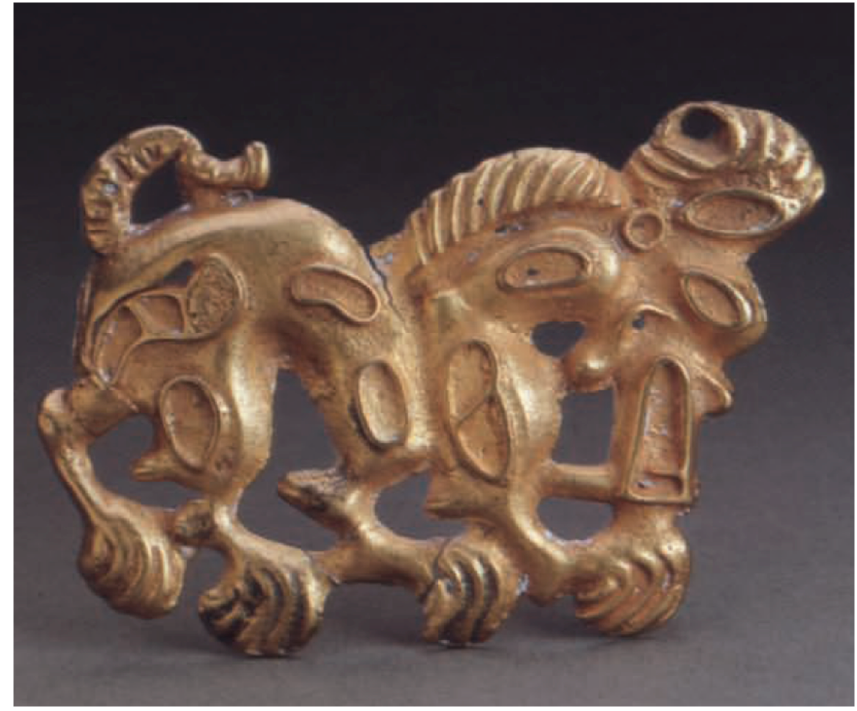
Figure 8. Beast-shaped plaque, gold, 9.5 cm, excavated from Liujiazi, Horqin Left Middle Banner Banner, Inner Mongolia; after (Watt et al. 2004, p. 127).